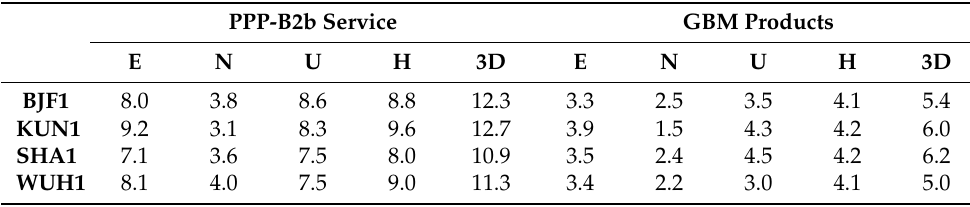
Table 6. The positioning accuracy of kinematic PPP at all four stations (unit: